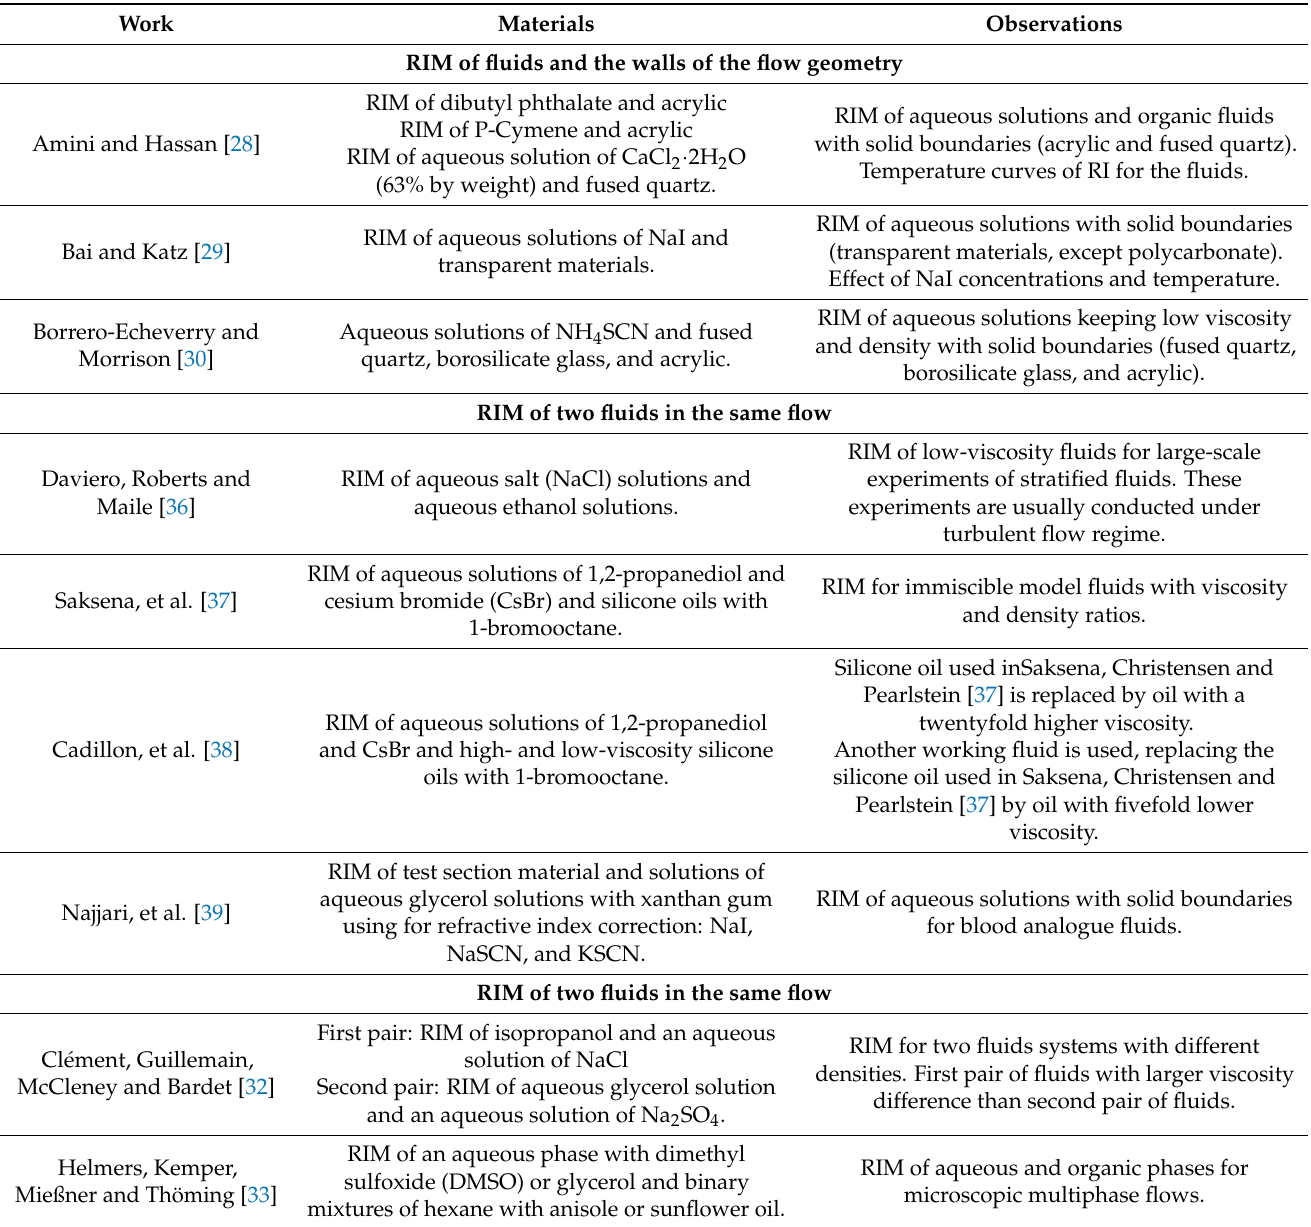
Table 1. List of works on refractive index